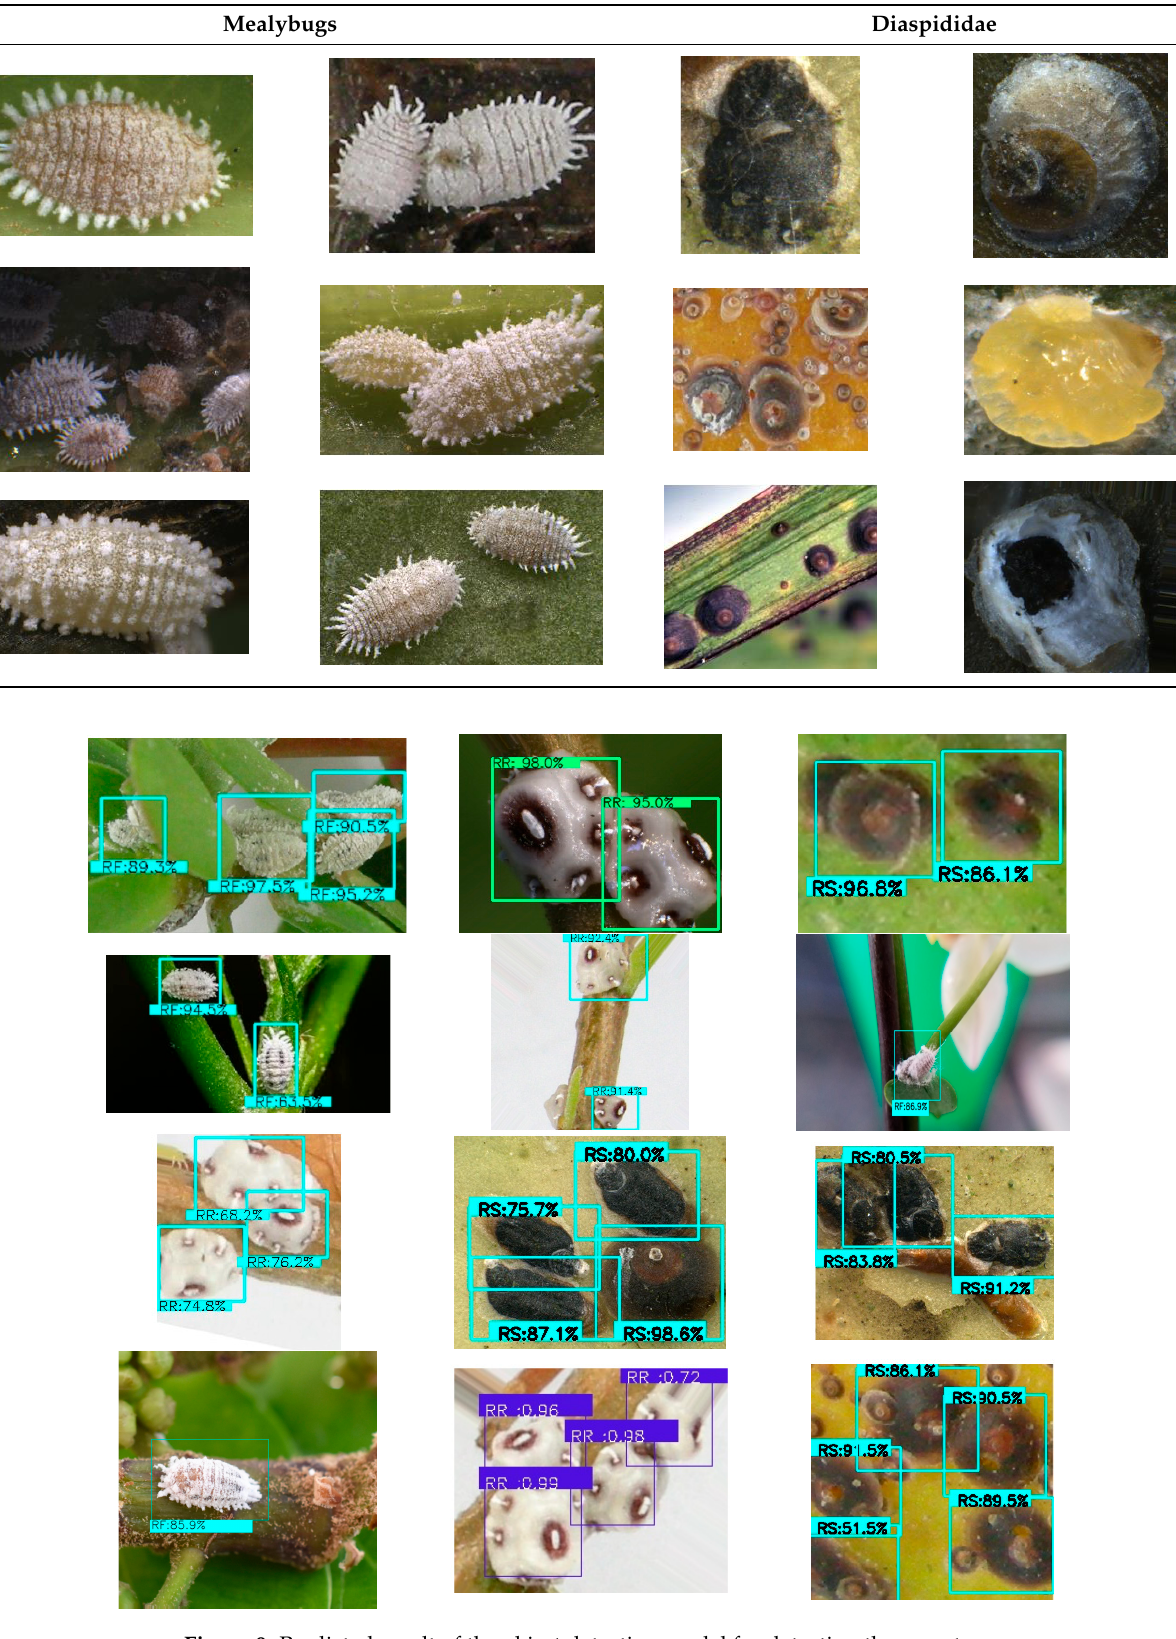
Figure 9. Predicted result of the object detection model for detecting three pests. After obtaining the identification outcome of the object detection models, the results of the scale disease detection system are further provided to the end user. A web interface and a smartphone are used to perform the task of pest detection application in real time. This study develops a web-based user interface system and combines the android mobile app to track the object detection outcome. The result of scale disease monitoring using the web-based user interface system is shown in Figure 10.